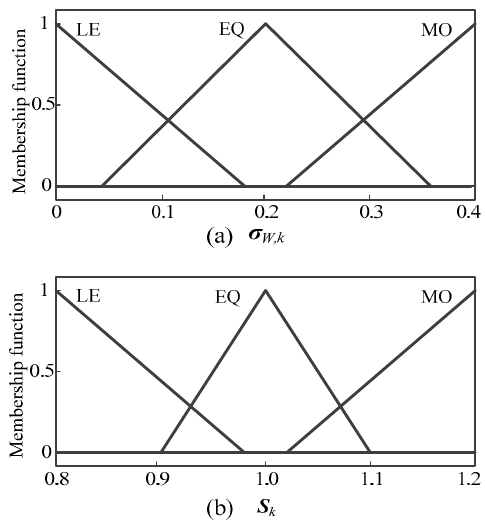
Figure 7. Membership functions of input and output variable of FIS: ( a ) Membership functions of input σ W , k ; ( b ) membership functions of output S k .